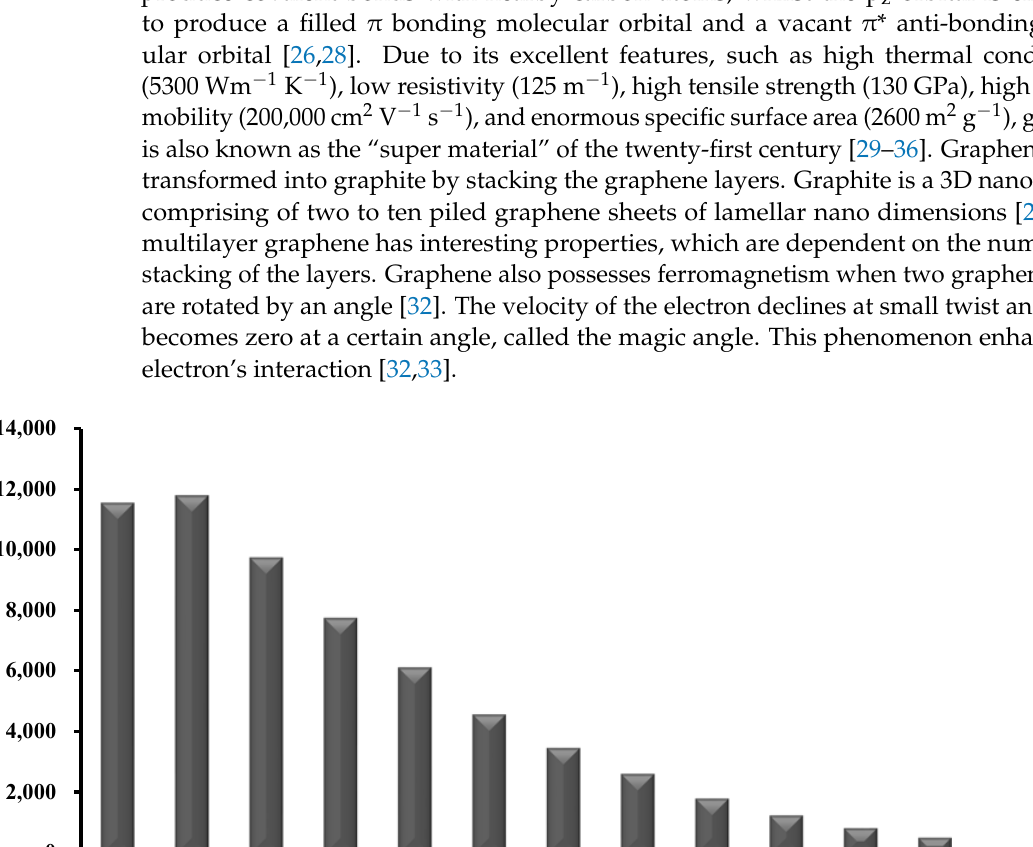
layer graphene has interesting properties, which are dependent on the number and stack- rotated by an angle [32]. The velocity of the electron declines at small twist angles and transfer, and (ii) substitutional doping. The latter approach is more effective because it becomes zero at a certain angle, called the magic angle. This phenomenon enhances the entails the replacement of carbon atoms by heteroatoms [41,42,50–54]. In surface transfer electron’s interaction [32,33]. doping, an interchange of electrons occurs between the surface-adsorbed dopant and graphene